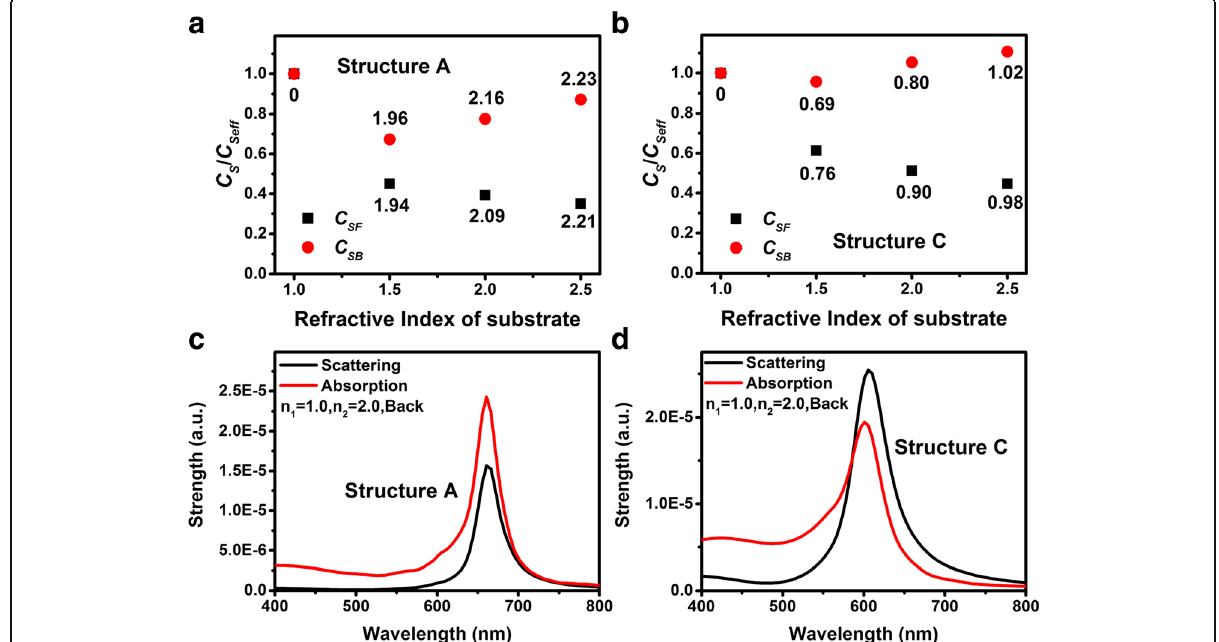
Fig. 5 a , b The ratios of coupling strengths C S /C Seff with various n 2 of structure A and structure C respectively. Black rectangular and red circular dots represent the front and back incident cases respectively. c , d Scattering and absorption spectra of structures A and C with fixed n 2 = 2.0 when light is incident from the